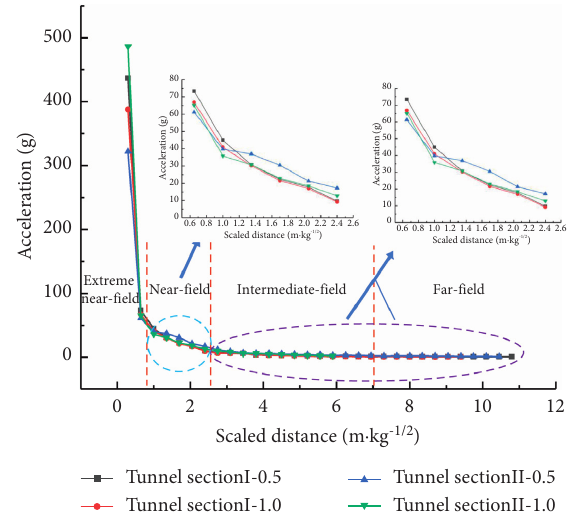
Figure 11: Vibration attenuation in different areas.